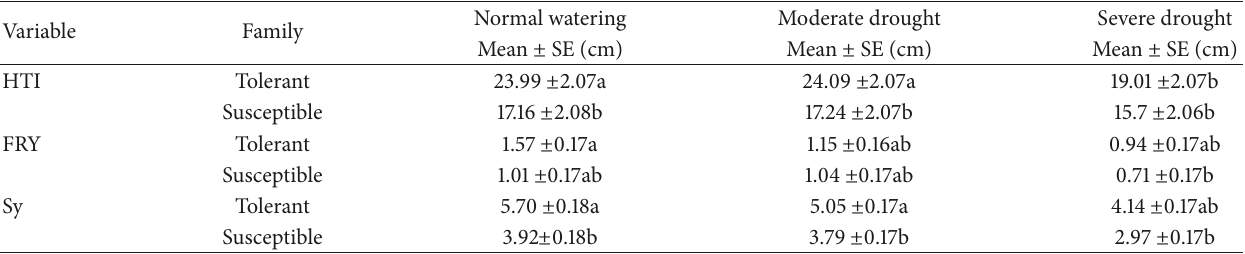
Table 8: Least squaremeans and standarderrorsof variousresponsevariables of seedlings fromtwo different families receiving threedifferent watering